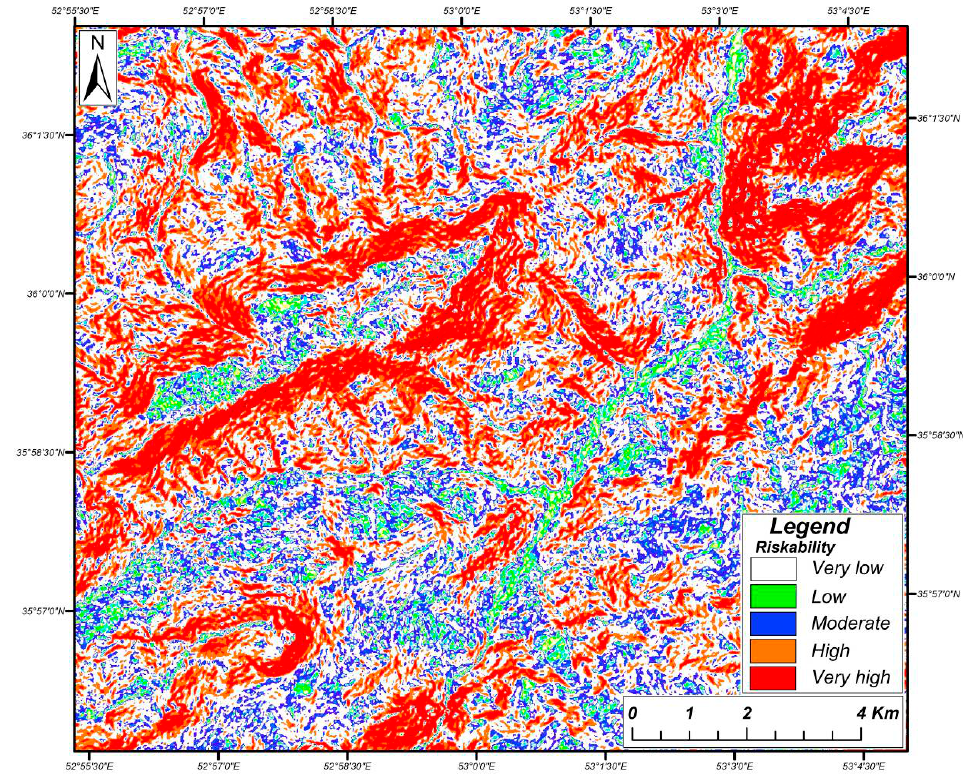
Figure 13. CNN-based landslide susceptibility map.